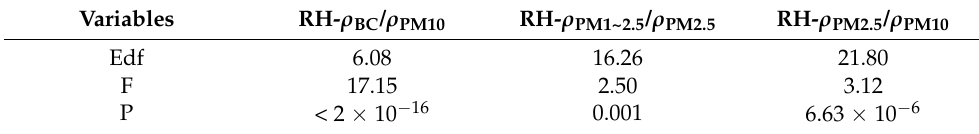
Table 8. At PM 2.5 pollution concentration, simulation results of the GAMs with the interaction effect.